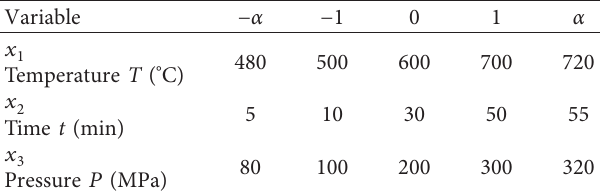
Table 1: The values of the experimental planning.